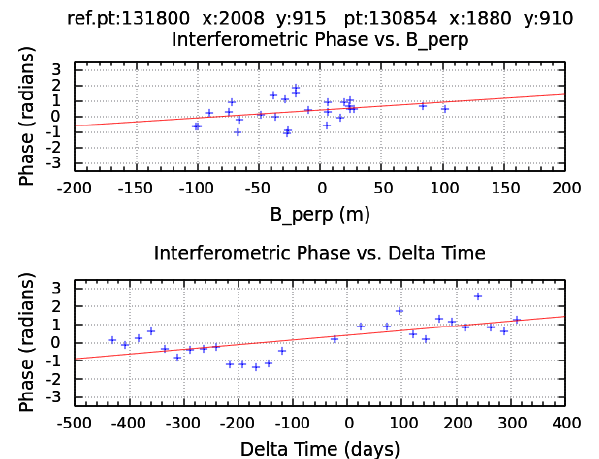
Figure 6. Interferometric point target analysis (IPTA) processing